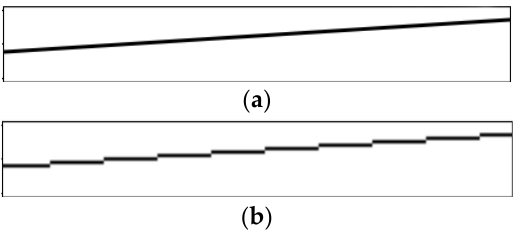
Figure 6. Contour jaggedness error. ( a ) Ideal boundary contour; ( b ) True boundary contour.